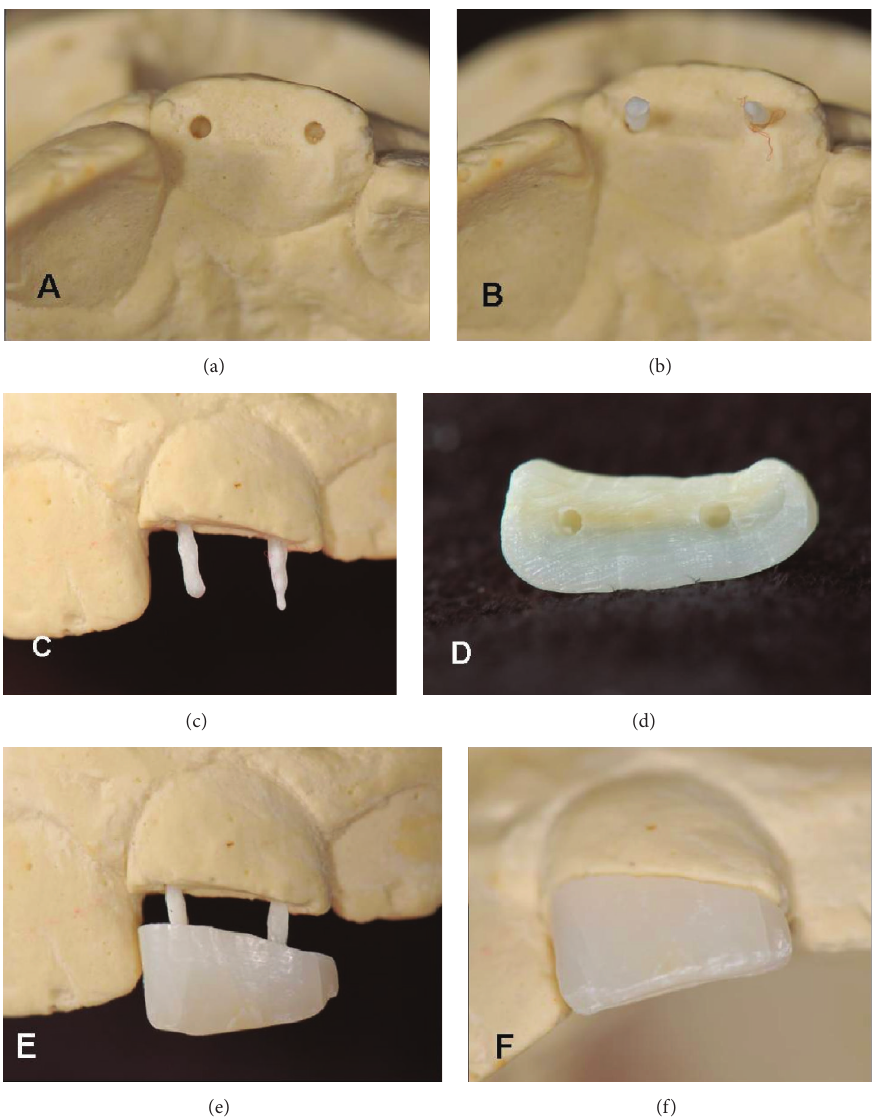
Figure 6: (a) Simulated holes in the model for placement of the biopins. (b) Biopins in place, incisal view. (c) Biopins in place, vestibular view. (d) Holes made in the fragment for adaptation of the biopins. (e) Laboratory sample of the fragment to the biopins. (f) Fragment suitably adapted to the plaster